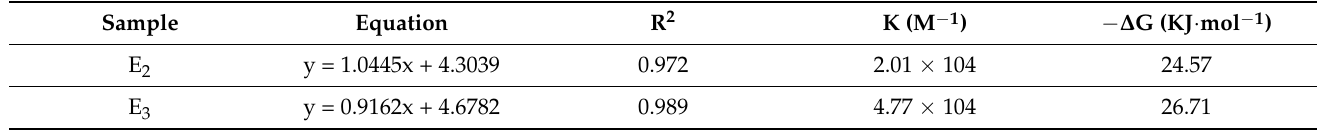
Table 3. Binding constants and binding free-energy values for the interactions of E 2 and E 3 with DNA based on CV data presented in Figure